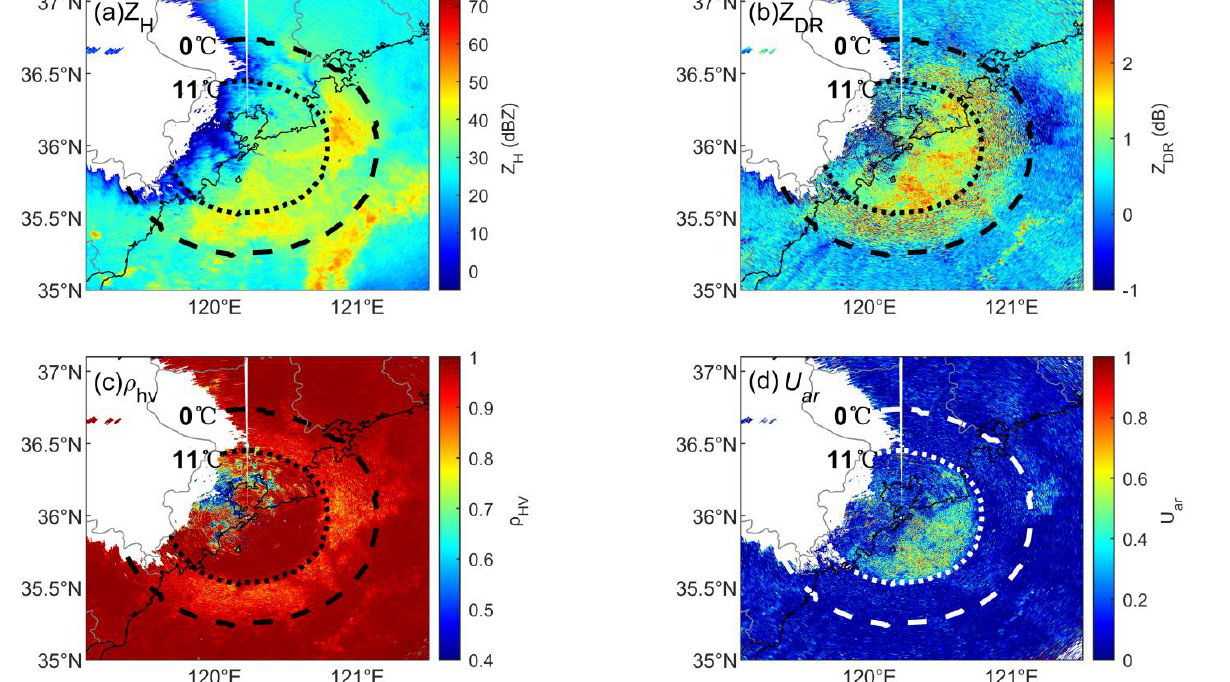
Figure 15. Sample PPI observations with BB from the S-band dual polarization weather radar. (The data time is 17 May 2020 23:51 LST. The elevation is 2.4°, which is the third level of a volume scan).